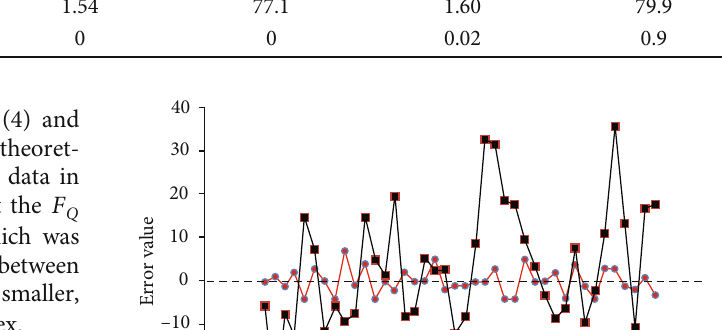
Table 11: Contrast with the classi fi cation result of rock mass quality and rock mass structure.